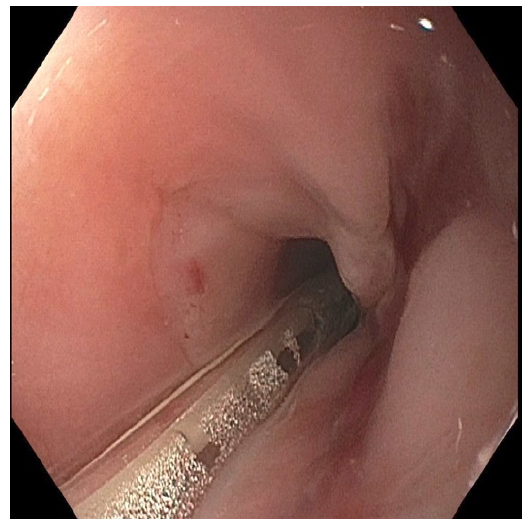
Figure 6. Endoscopy showing esophageal stenosis with friable mucosa in the middle esophagus, one month following button battery ingestion and removal.